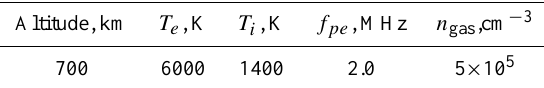
Table 1. Plasma parameters for the